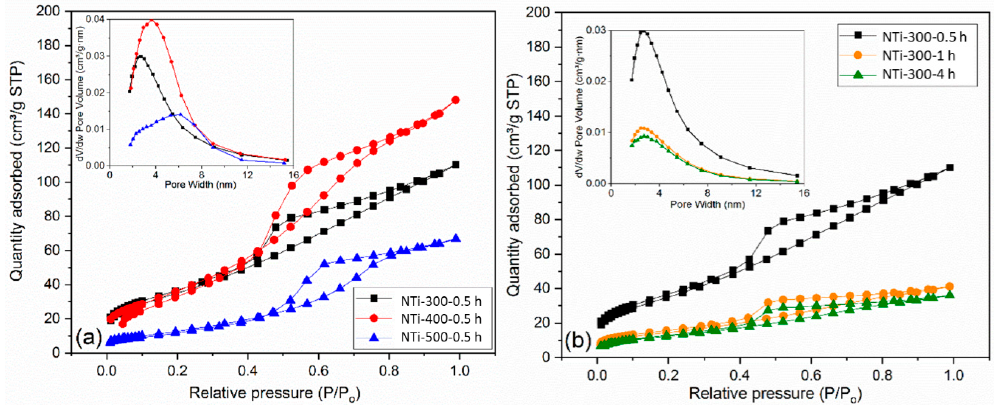
Figure 4. The N 2 adsorption–desorption isotherms: ( a ) N-TiO 2 with different annealing temperatures, and ( b ) N-TiO 2 with different annealing time. Inserted in ( a , b ) are pore size distributions. Black: NTi- 300-0.5 h, Orange: NTi-300-1 h, Green: NTi-300-4 h, Red: NTi-400-0.5 h, Blue: NTi-500-0.5 h.